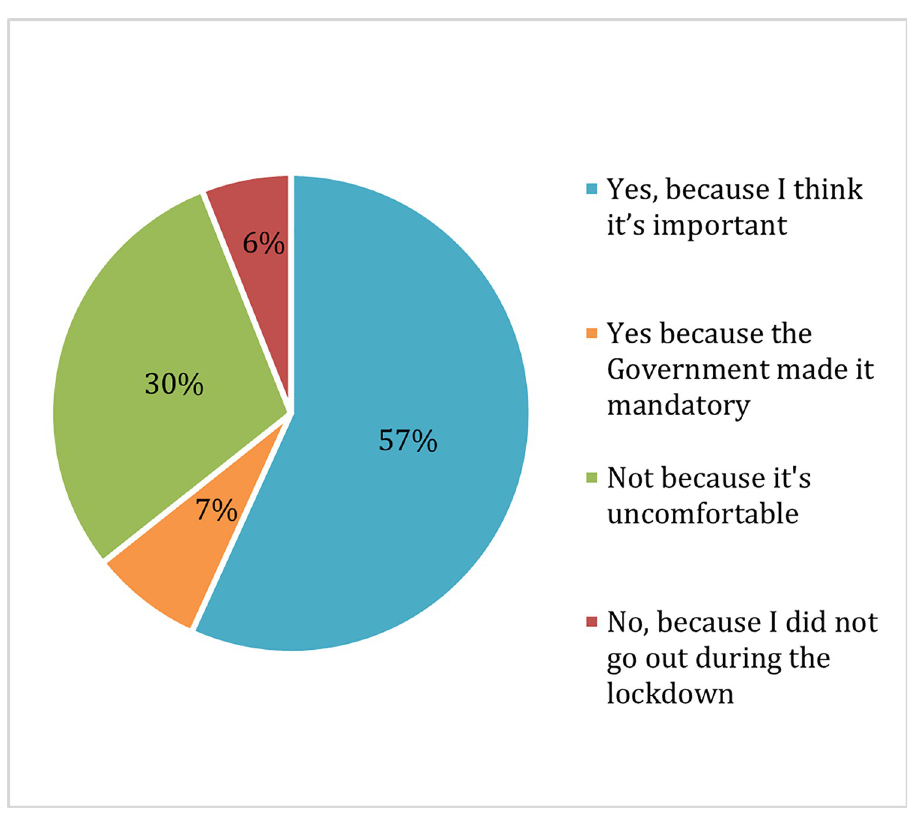
Fig 1. Reasons for wearing and not wearing face masks during the